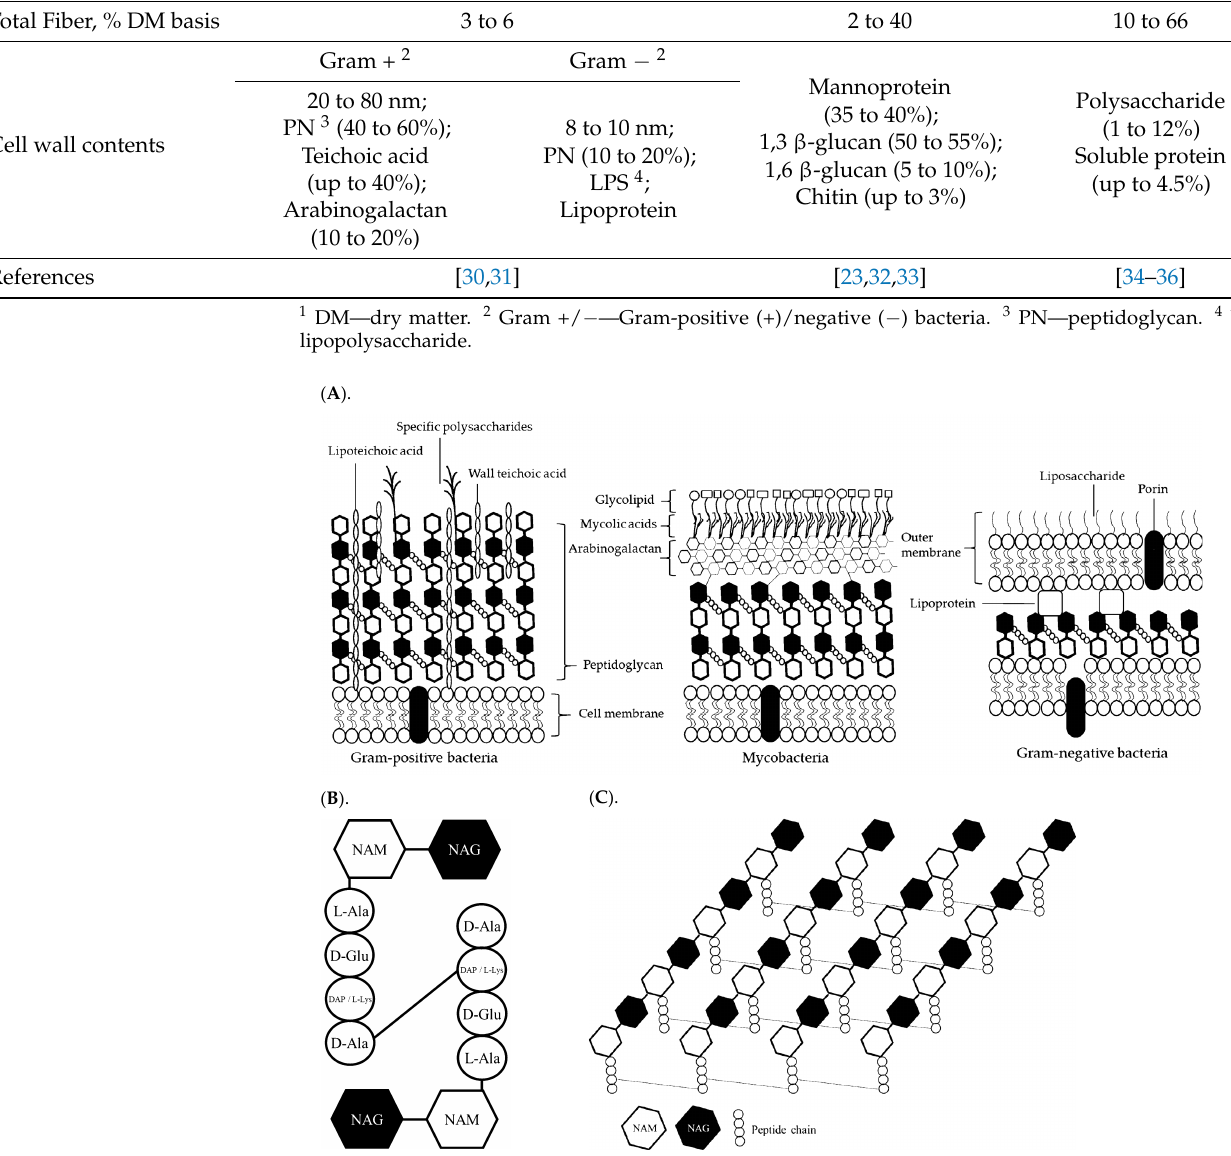
Figure 1. The structure of Gram-positive and Gram-negative bacterial cell walls ( A ), peptidoglycan (PG) structure ( B ), and the cross-linking of PG chains in bacteria ( C ). Concepts were based on Koch (2006) [37]; Kang et al. (2016) [38]; Pazos and Peters (2019) [25]. LPS, lipopolysaccharides; NAM, N- acetylmuramic acid; NAG, N-acetylglucosamine; L-Ala, L-alanine; D-Glu, D-glutamic acid; DAP, Diaminopimelic acid; L-Lys, L-lysine; D-Ala, D-Alanine.